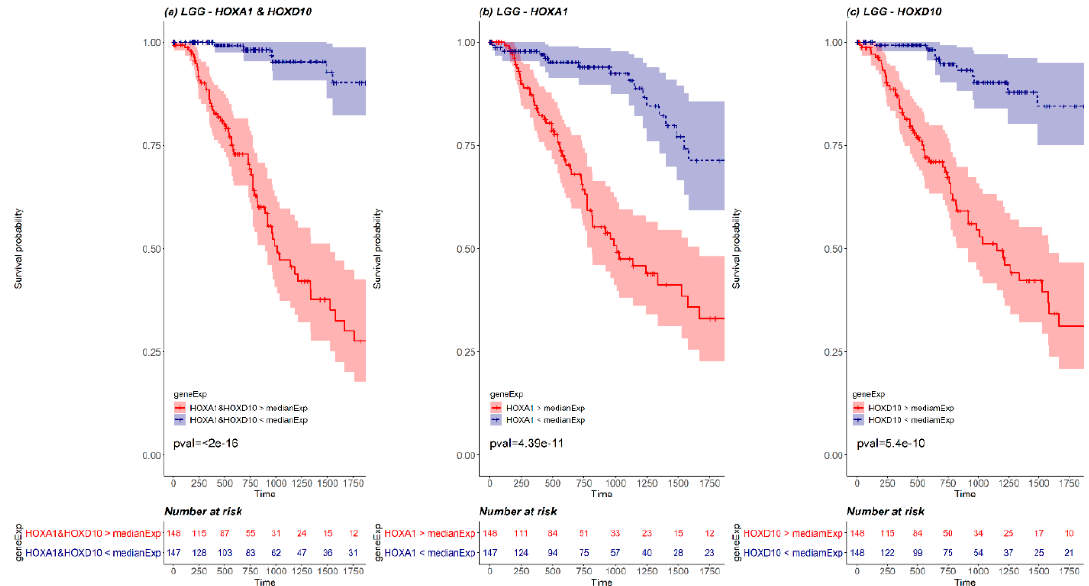
Figure 5. A KM plot of HOXA1 and HOXD10 pair ( a ) versus separate KM plots for each of HOXA1 ( b ) and HOXD10 ( c ) in LGG. The red line represents the survival of patients with expression higher than median expression, and the blue line represents the survival of patients with expression lower than median expression. The pink and the light blue background of the lines mark the confidence interval. Out of 527 LGG patients, there were 148 patients with both HOXA1 and HOXD10 expressed above LGG median expression (marked in red in the risk table below graph) and 147 patients with both HOXA1 and HOXD10 expressed below LGG median expression (marked in blue in the risk table below graph).